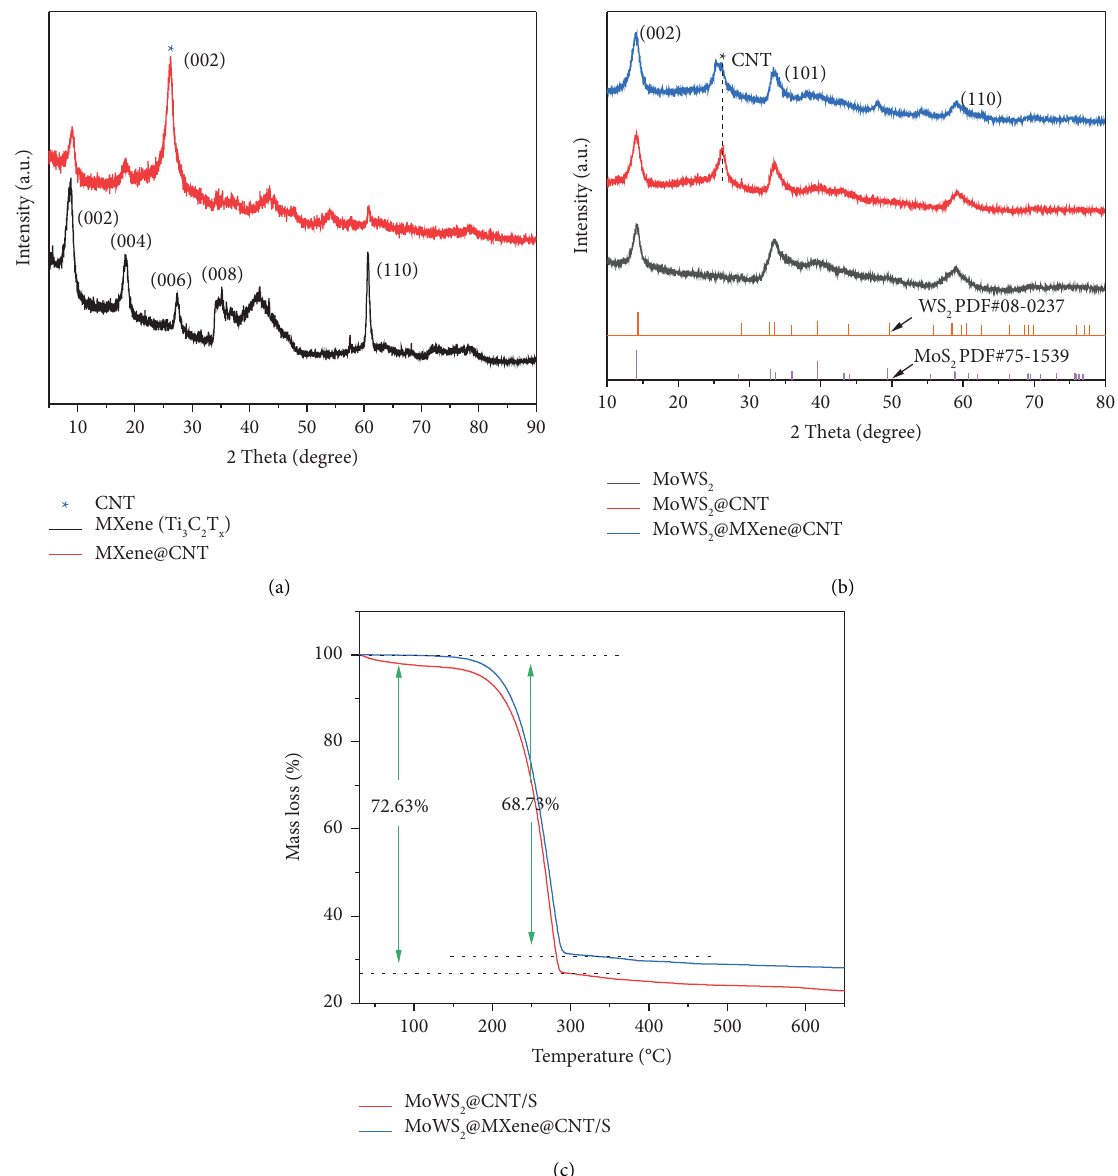
Figure 2: (a) XRD patterns of MXene (Ti 3 C 2 T x ) and MXene@CNT; (b) XRD patterns of MoWS 2 , MoWS 2 @CNT, and MoWS 2 @MXene@ CNT; (c) TGA curves of MoWS 2 @MXene@CNT/S and MoWS 2